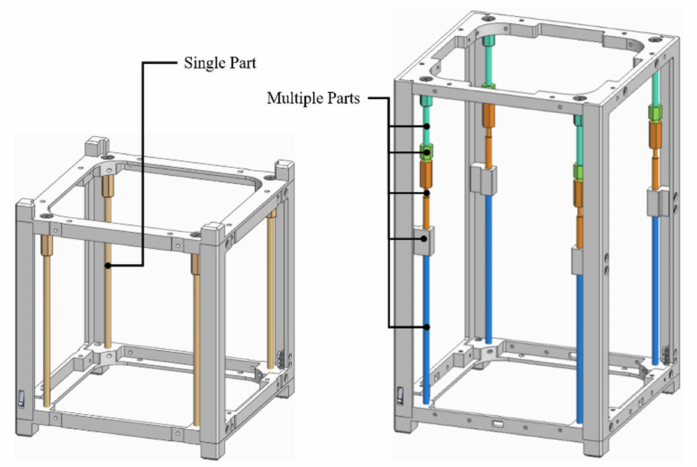
Figure 24. Configuration of board supporting rods of CubeSats (left: Timon, right: